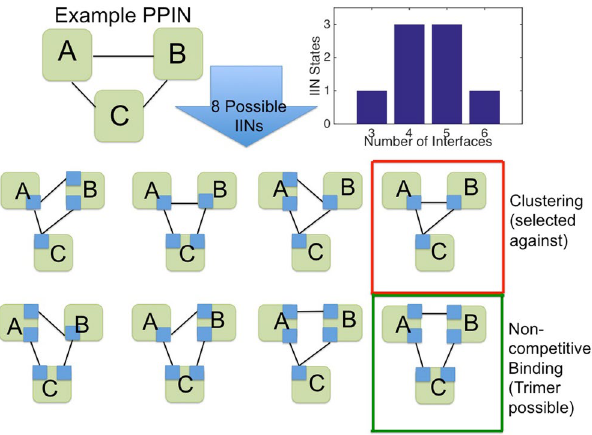
Figure 3. Each PPIN has many possible IINs, and only some are good for promoting selectivity. For the simple PPIN with three interacting proteins, there are 8 possible IINs with either 3, 4, 5 or 6 interfaces (blue squares). Because each IIN has different motifs present, only a subset will be favored in biological networks. The top row contains IINs with chain motifs or a triangle motif (red box), which are bad for promoting selectivity and less common in biological IINs. The bottom row contains favorable motifs, and in the green box is the only IIN that allows a true protein trimer to form. IINs with 4 or 5 interfaces are most common, as counted in the histogram. The same trend holds for much larger PPINs, with the sparse and dense IINs becoming increasingly rare, and hub interfaces less